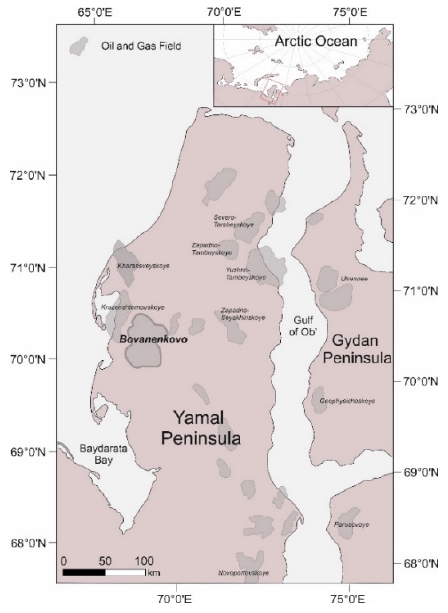
Figure 1. Location of the Bovanenkovo gas field.